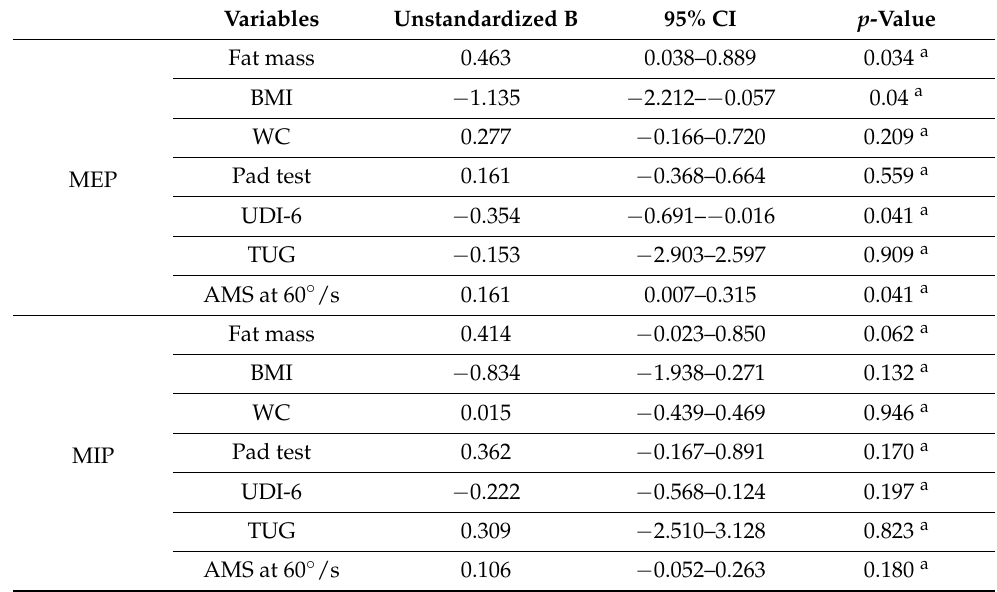
Table 3. Regression analysis summary for factors impacting on MEP and MIP for women with SUI.